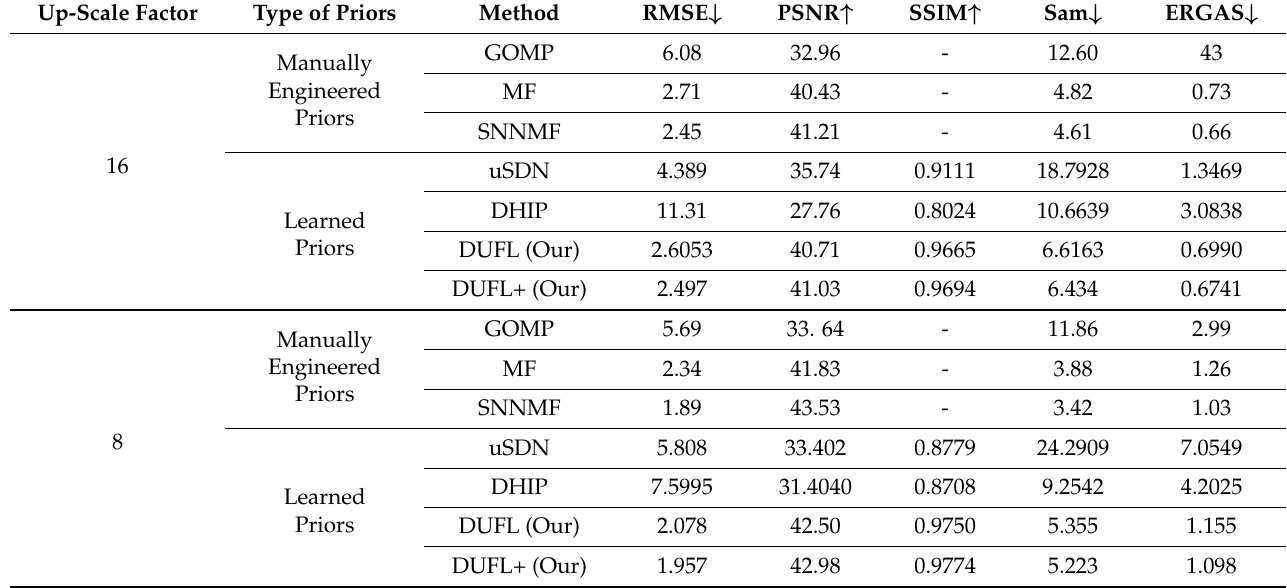
Table 2. Comparison of the evaluation results using the proposed methods with those obtained using the unsupervised SoTA methods, including the manually engineered image priors (GOMP [50], MF [16], SNNMF [51]) and automatically learned image priors (DHIP [24] and uSDN [41]) in the CAVE dataset for up-scale factors of 16 and 8. Up-Scale